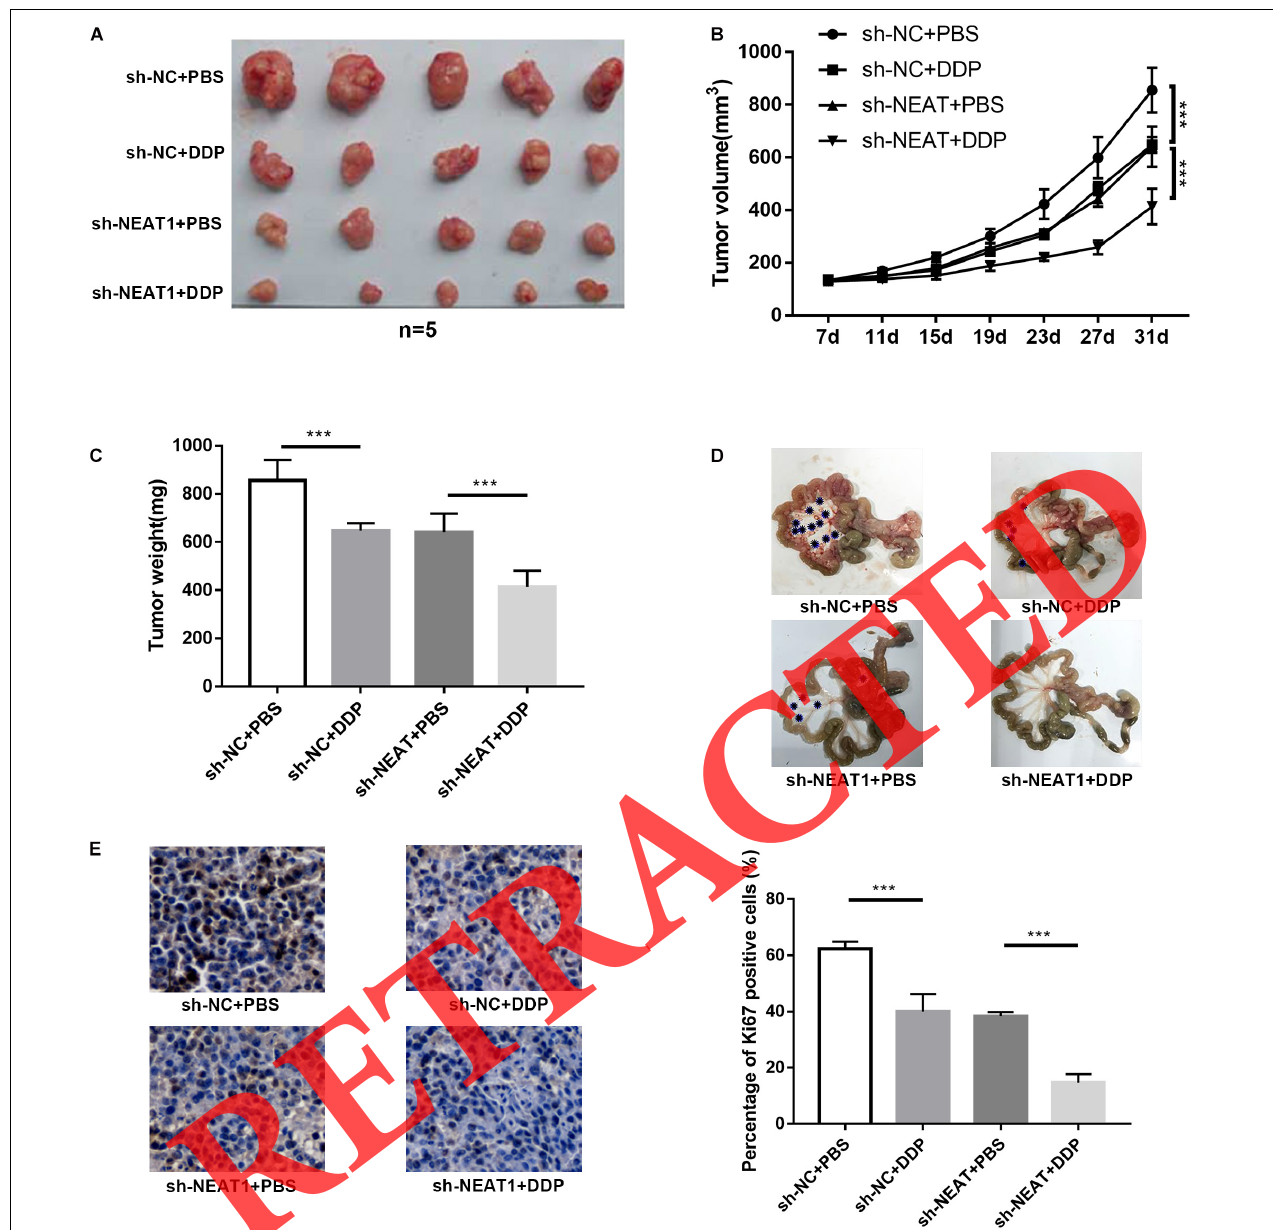
FIGURE 3 | lncRNA NEAT1 promoted cisplatin resistance in vivo. (A) Photos of tumors in xenograft-transplanted nude mouse tumor models after the treatment of oral cisplatin (qd) or NS as control for 31 days in different groups. (B) Measurements of tumor volumes every 4 days using calipers. (C) Weights of tumors in xenografts of different groups. (D) Representative images of the mesenteric membrane of six mice per group are shown. *Indicates tumor nodule. (E) IHC analysis of Ki-67 expression in xenografts of different groups. All tests were conducted for at least three times. Data were reported as mean ± SD. * p < 0.05, ** p < 0.01, *** p <